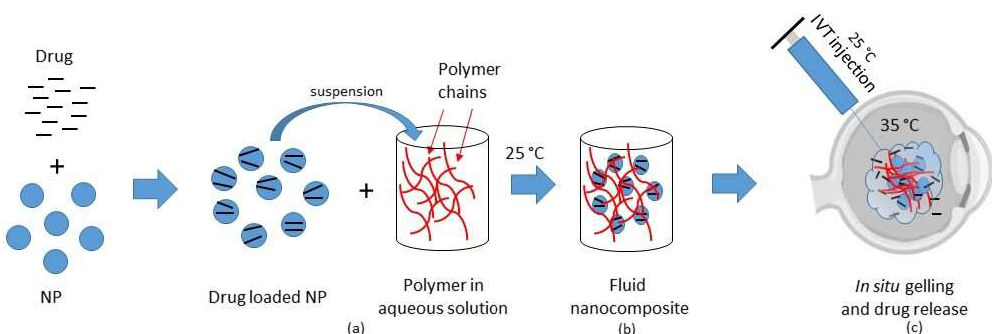
Figure 1. Possible scheme of preparation and intravitreal injection of a thermosensitive nanocomposite system: ( a ) Drug loaded NP are suspended in a polymeric solution at 25 ◦ C. ( b ) Polymeric solution-suspended NP form a fluid injectable nanocomposite system at 25 ◦ C. ( c ) The fluid nanocomposite system is injected in the vitreous at 25 ◦ C; the temperature-induced phase transition occurs at 35 ◦ C, resulting in in situ gel formation and sustained drug release.